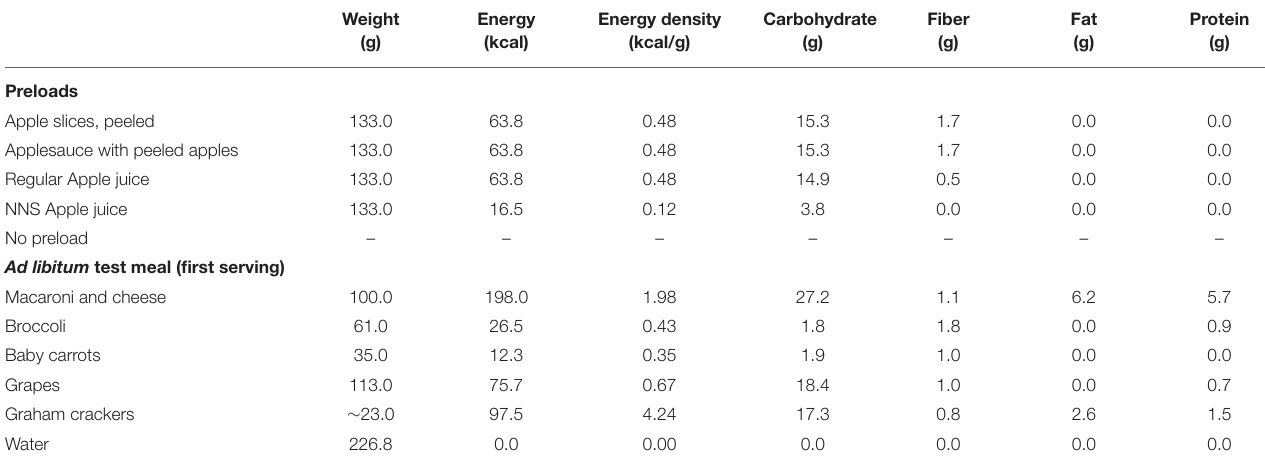
TABLE 1 | Weight, energy content, energy density, and macronutrient composition of preloads and standardized ad libitum test meal